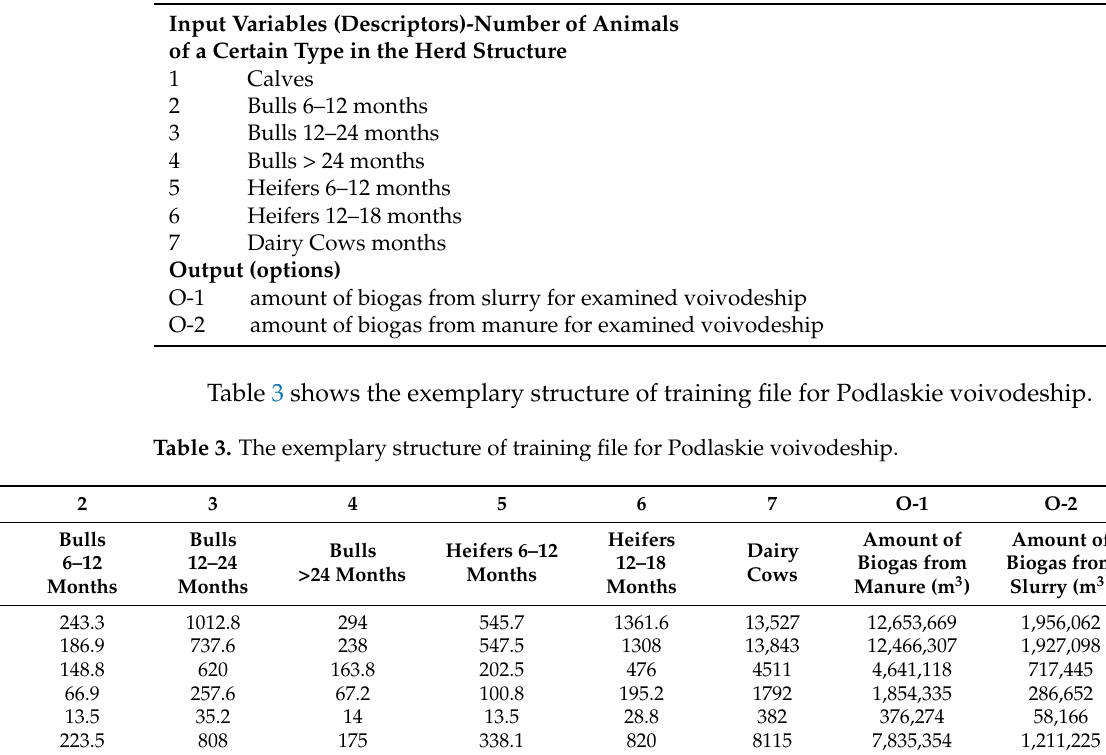
Table 2. Input and output variables of created ANNs; values without dimensions were considered in the model.